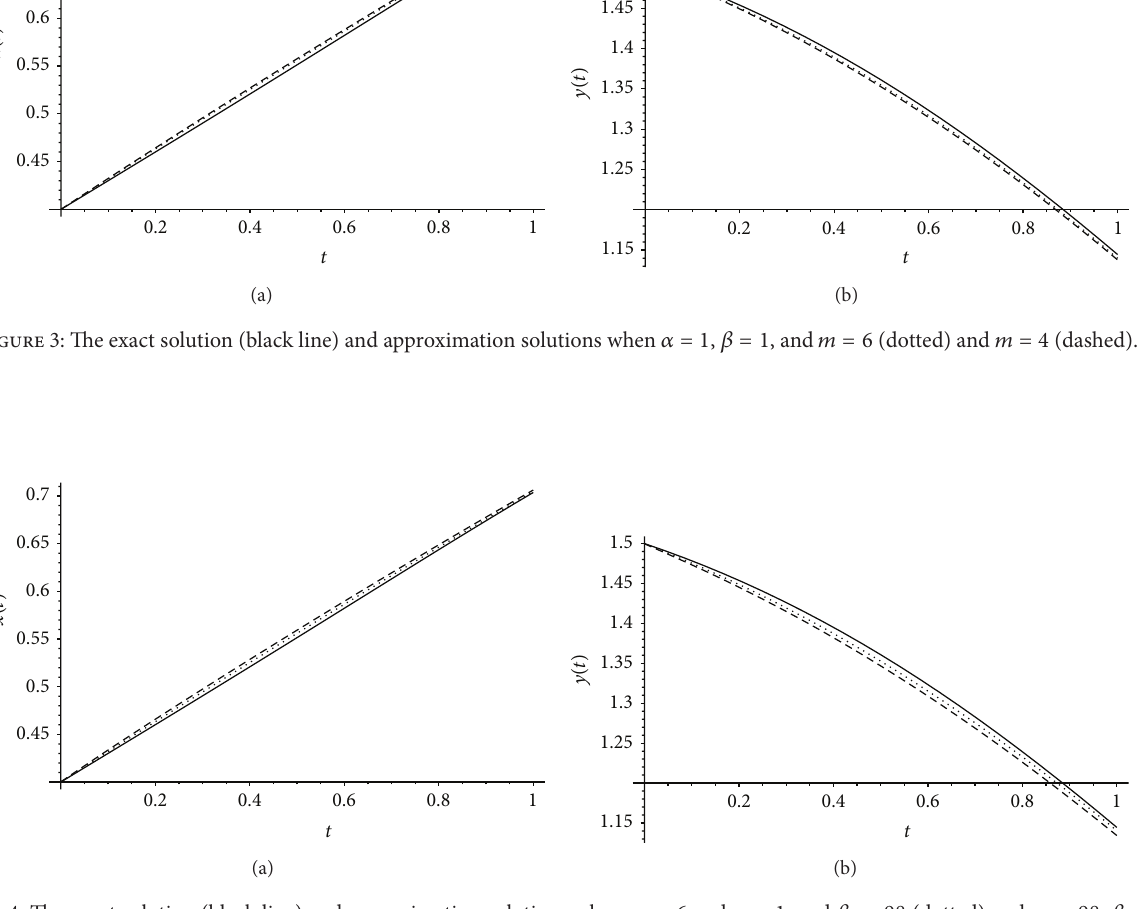
Figure 4: The exact solution (black line) and approximation solutions when 𝑚 = 6 and 𝛼 = 1 , and 𝛽 = .98 (dotted) and 𝛼 = .98 , 𝛽 = .95